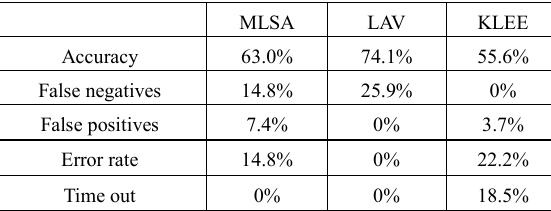
Table 2. Comparison of MLSA with LAV and